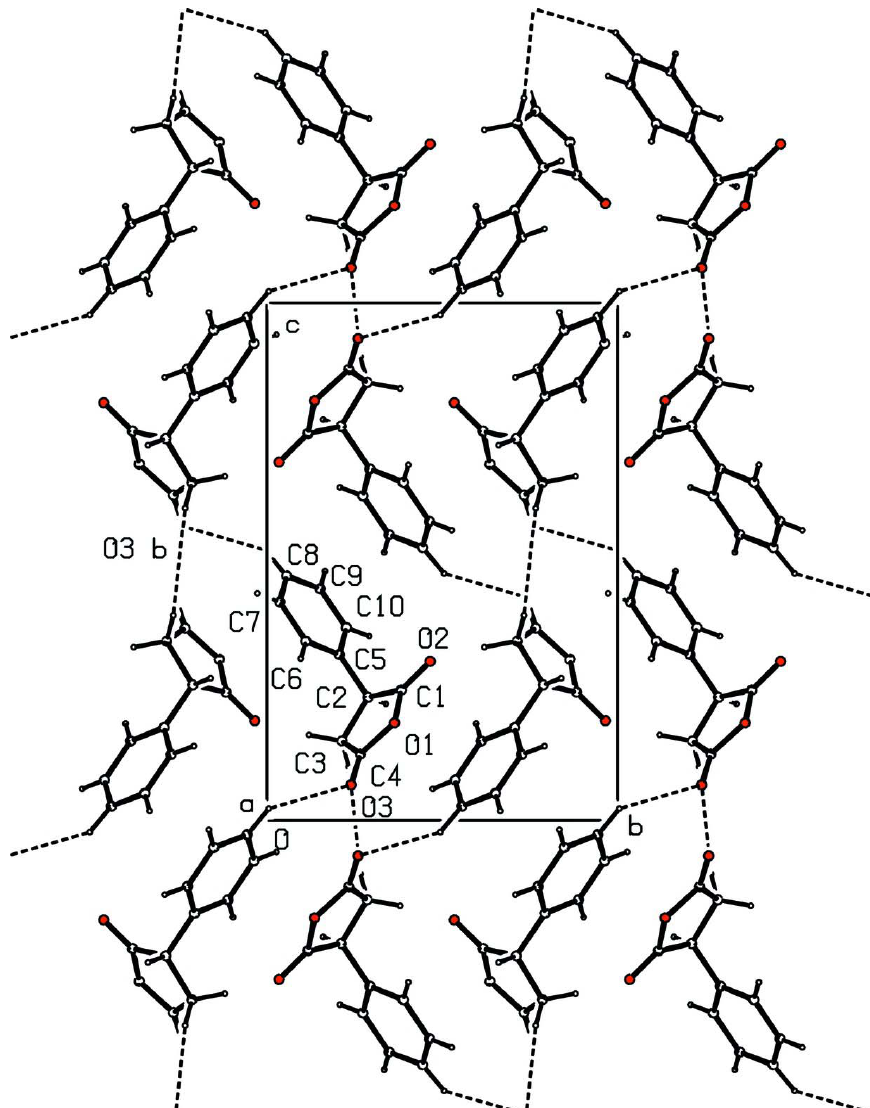
Figure 2 A projection of the title compound (I) viewed down the a axis. Weak C—H···O contacts are indicated as dashed